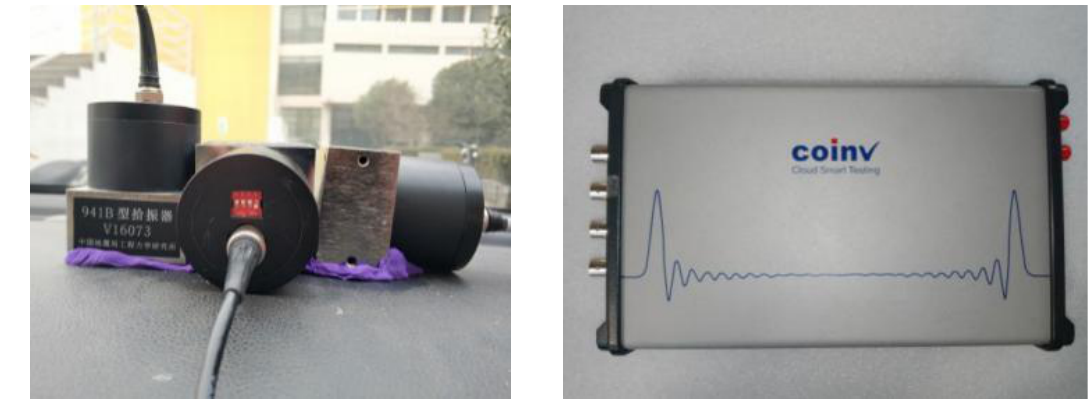
Figure 3. Ultra-low-frequency accelerometers and corresponding data acquisition instrument.